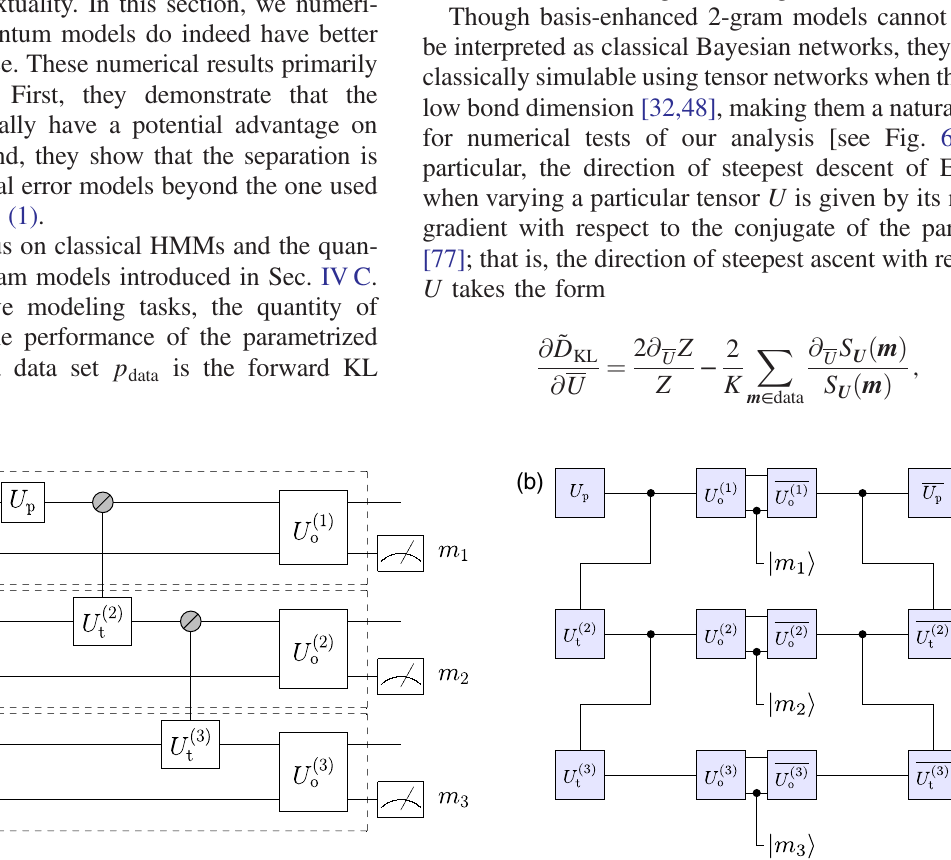
constructs the prior, and p